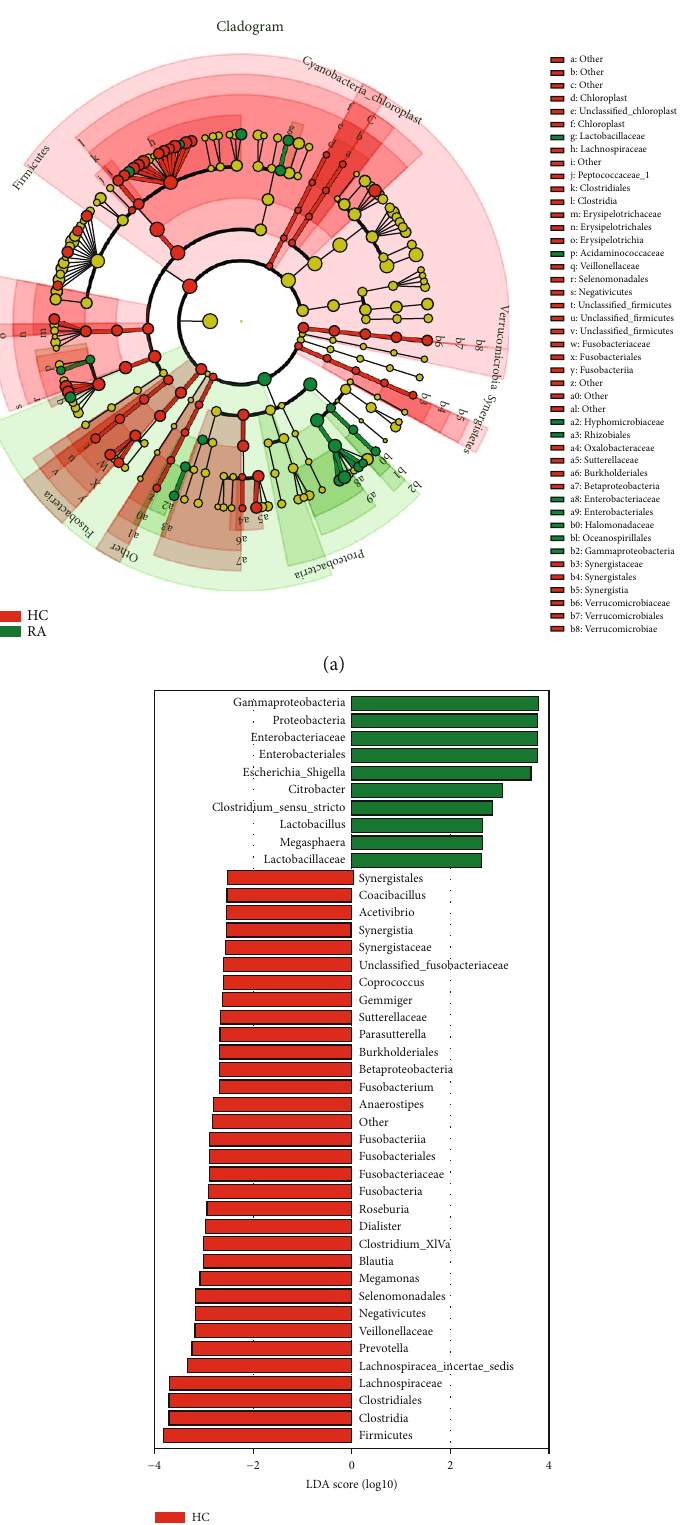
Figure 4: (a, b) LefSe analysis was performed to identify di ff erentially abundant taxa, which are highlighted on the phylogenetic tree in cladogram format (a) and for which the LDA scores are shown